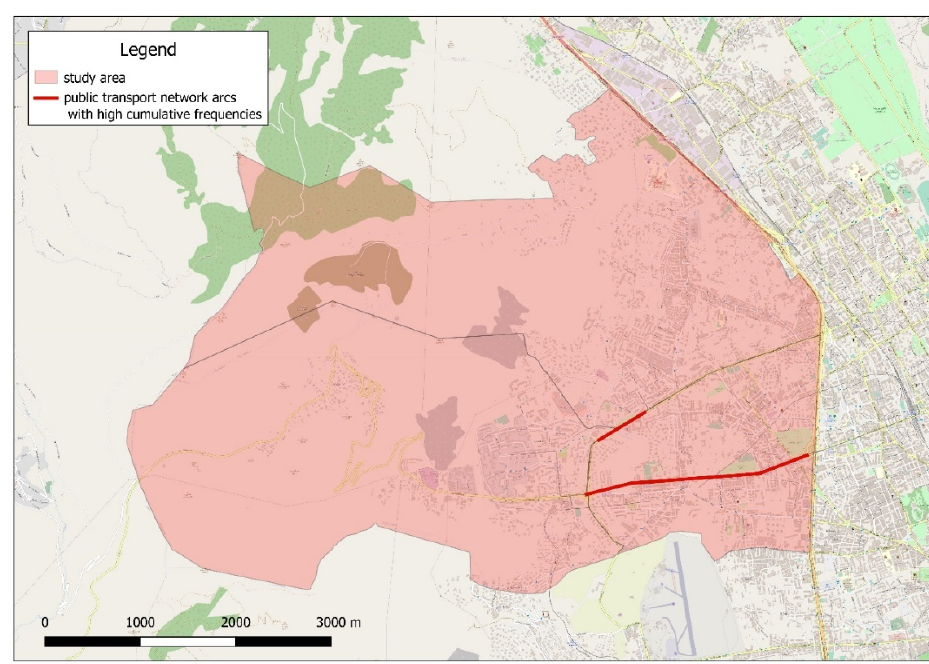
Figure 4. Public transport network arcs with high cumulative frequencies.